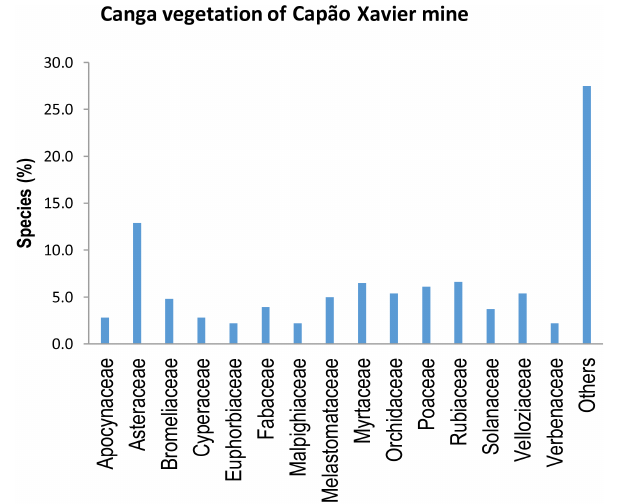
Figure 3. The 15 families of Angiosperms with higher richness of species found in canga vegetation in Capão Xavier mine. The num- bers represent the percentage contribution of each family to species